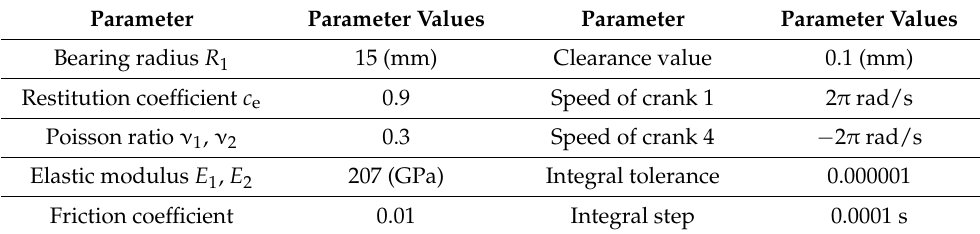
Table 3. Clearance simulation